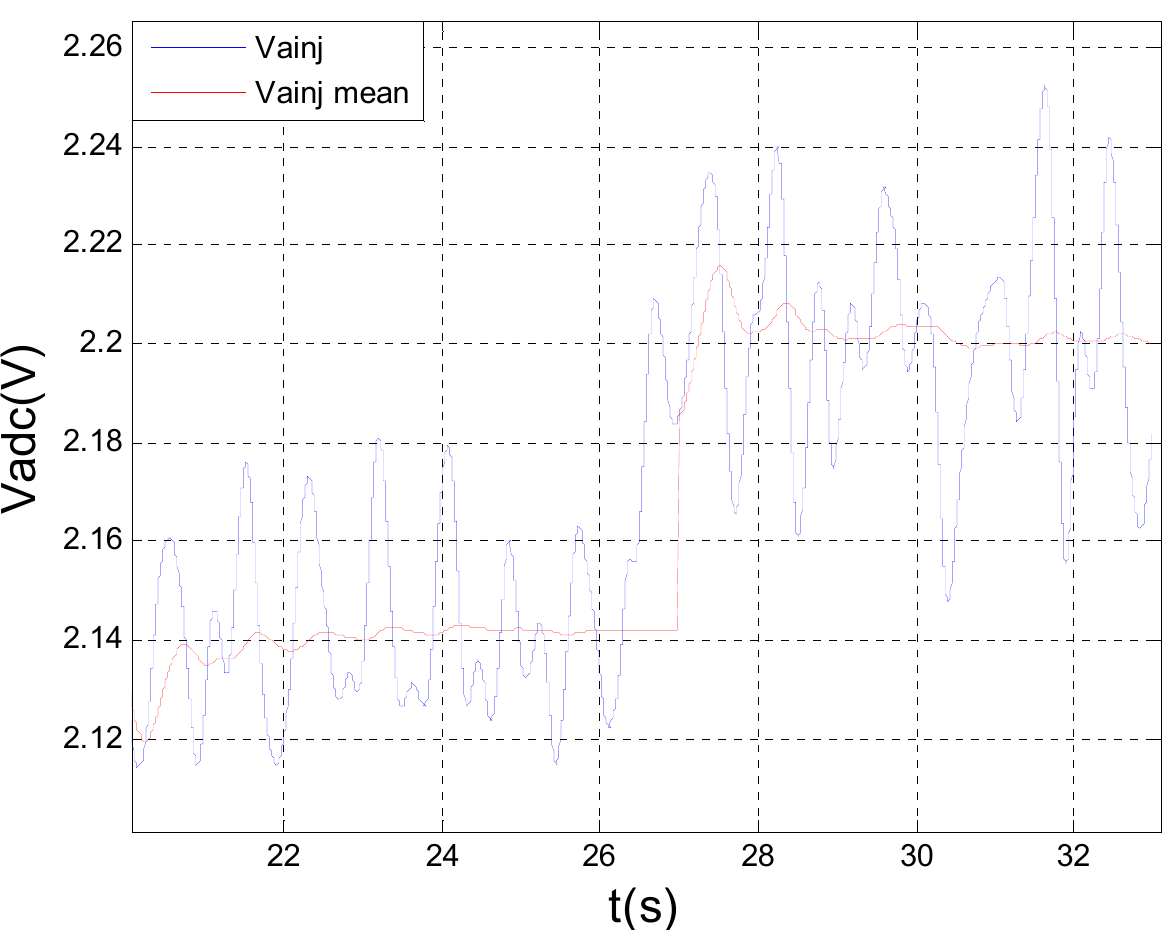
Figure 5. Vainj value at the two different dead-time values.